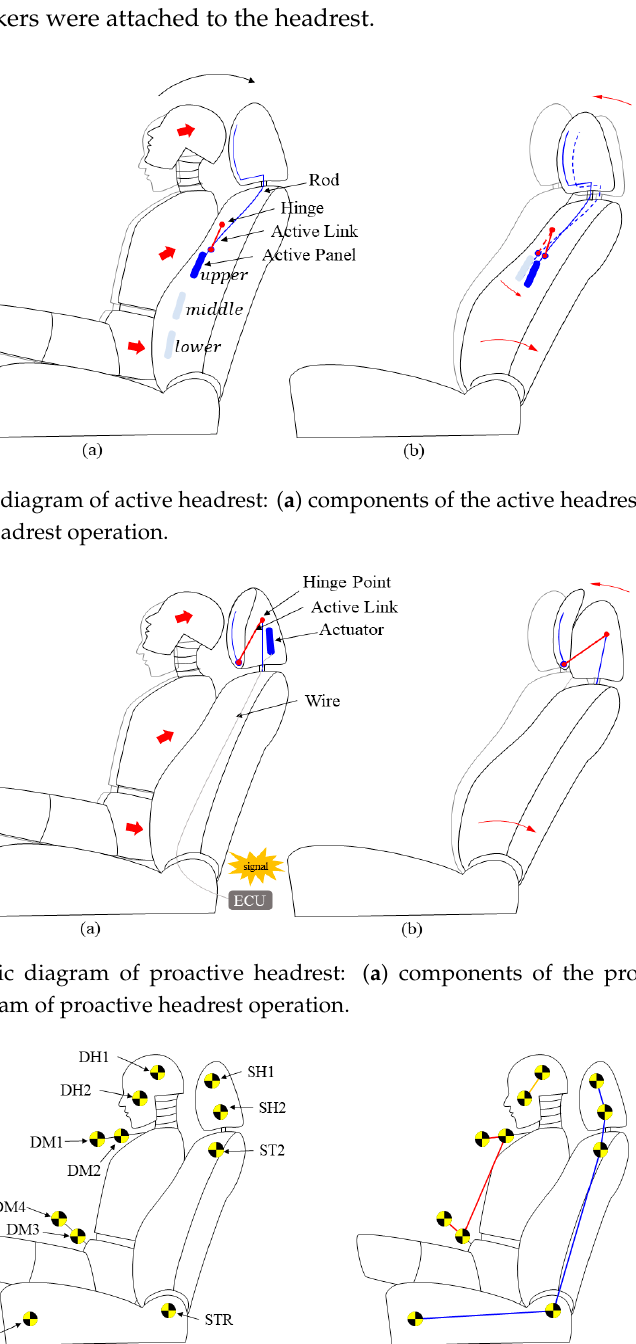
Figure 3. Schematic diagram of proactive headrest: ( a ) components of the proactive headrest; ( b ) conceptual diagram of proactive headrest operation.